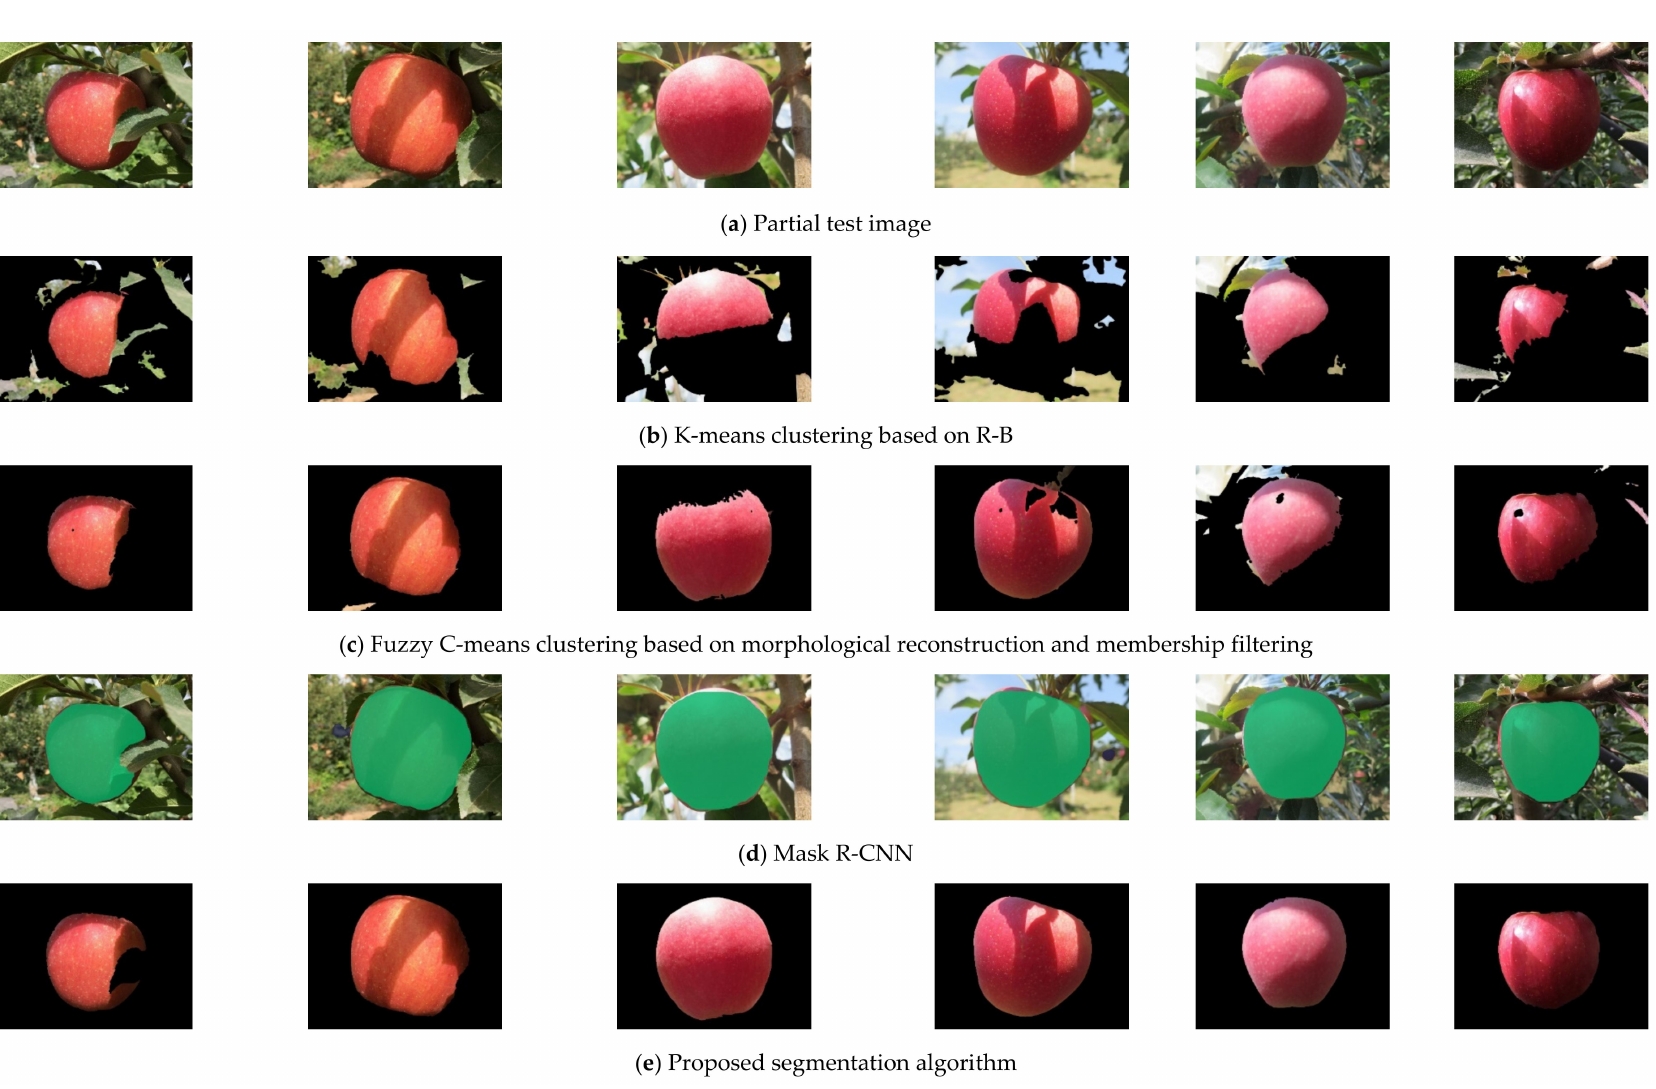
Figure 8. Comparison tests using different